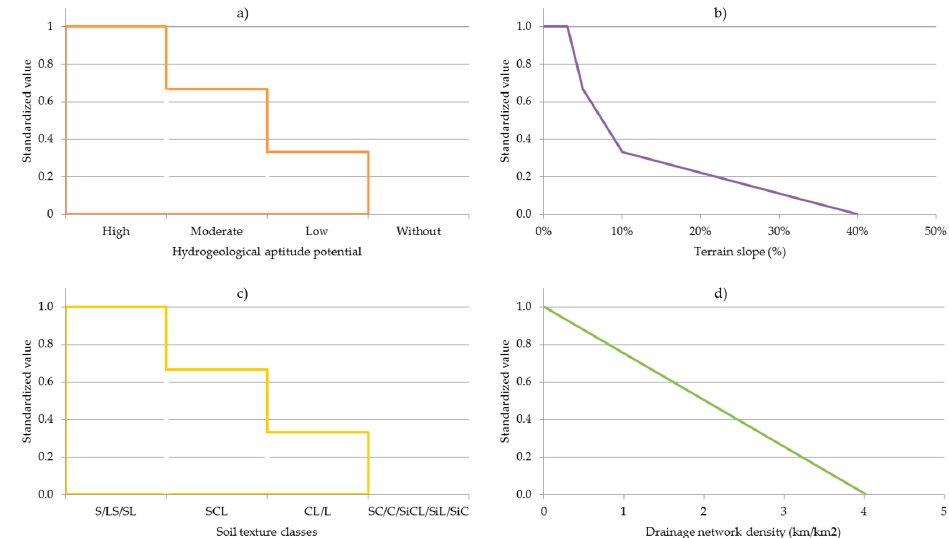
Figure 7. Standardization of the four criteria used in the WLC. ( a ) hydrogeological aptitude; ( b ) terrain slope; ( c ) soil texture; and ( d ) drainage network density.